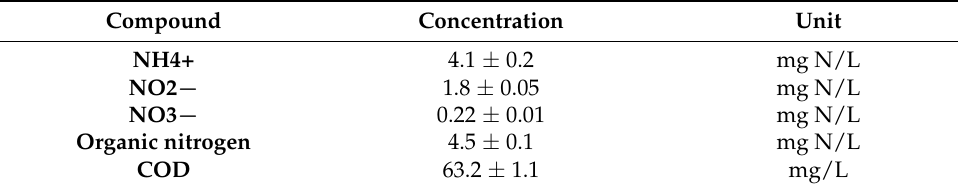
Table 1. The measured concentrations of ammonia (NH 4+ ), nitrite (NO 2 − ), nitrate (NO 3 − ), organic nitrogen, and COD in the SE. COD concentration was composed of materials with three levels of biodegradability: readily–rbCOD (glucose), moderate–mbCOD (LB broth), and slow–sbCOD (humic acids). Further details are provided in Supplemental Tables S2 and